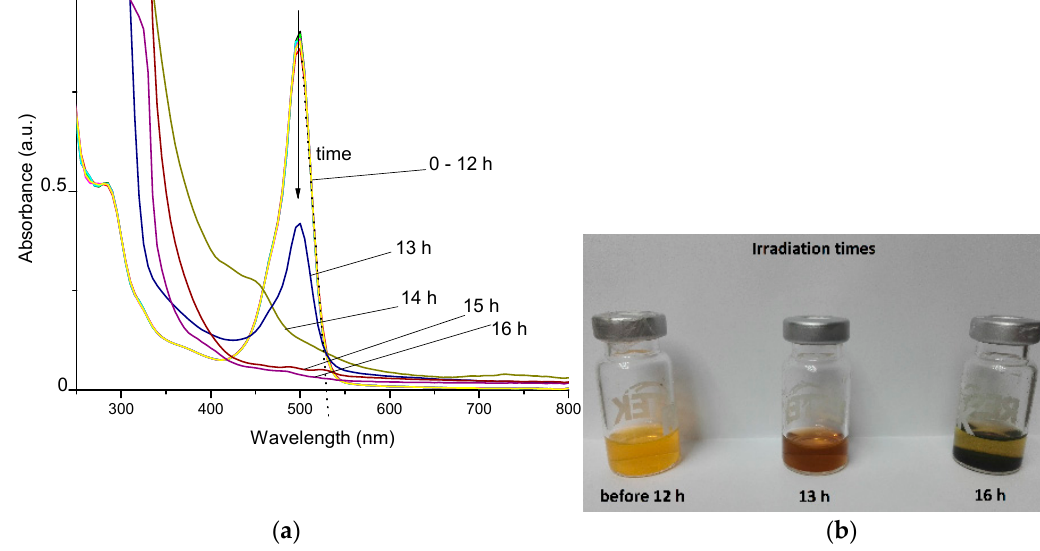
Figure 3. ( a ) UV-visible spectra of G4-F nanoaggregates after different irradiation times. The dotted line indicates the extrapolated wavelength for the estimation of the optical band gap. ( b ) Digital camera images of the samples with their respective irradiation times.